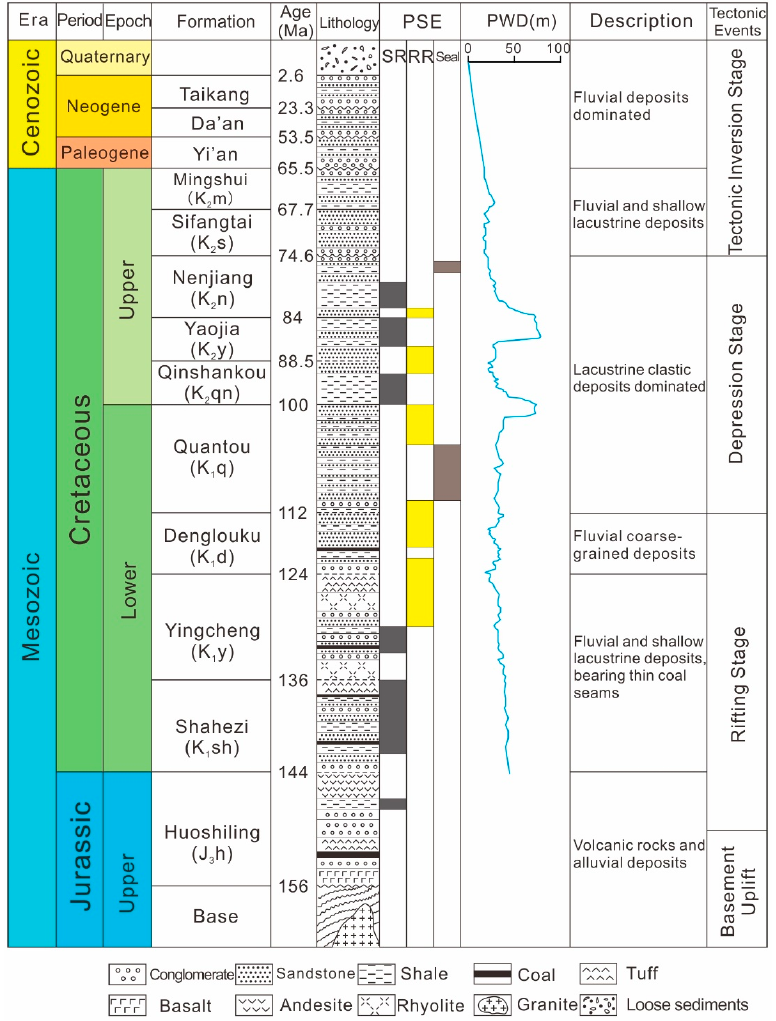
Figure 2. Lithostratigraphy of the Changling Depression (adapted from Wang et al. and Lin et al. [47,48]. The paleo water depth curve was modified after Zhang and Ren [49] (PSE = petroleum system elements, SR = source rock, RR = reservoir rock, PWD = paleo water depth).